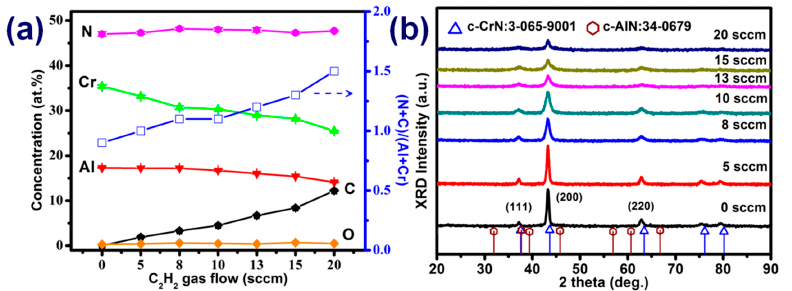
Figure 1. ( a ) Element concentrations and ( b ) XRD profiles of AlCrCN films deposited under various C 2 H 2 flow